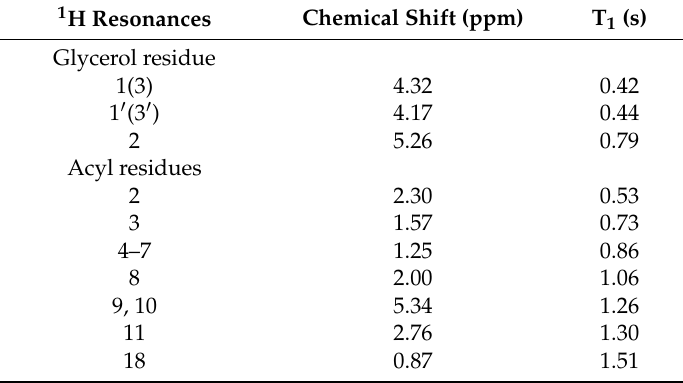
Table 10. Longitudinal relaxation times T 1 of proton nuclei of acyl chains of olive oil triacylglycerides. Reprinted, with permission, from [20]. Copyright 1999, Elsevier Science